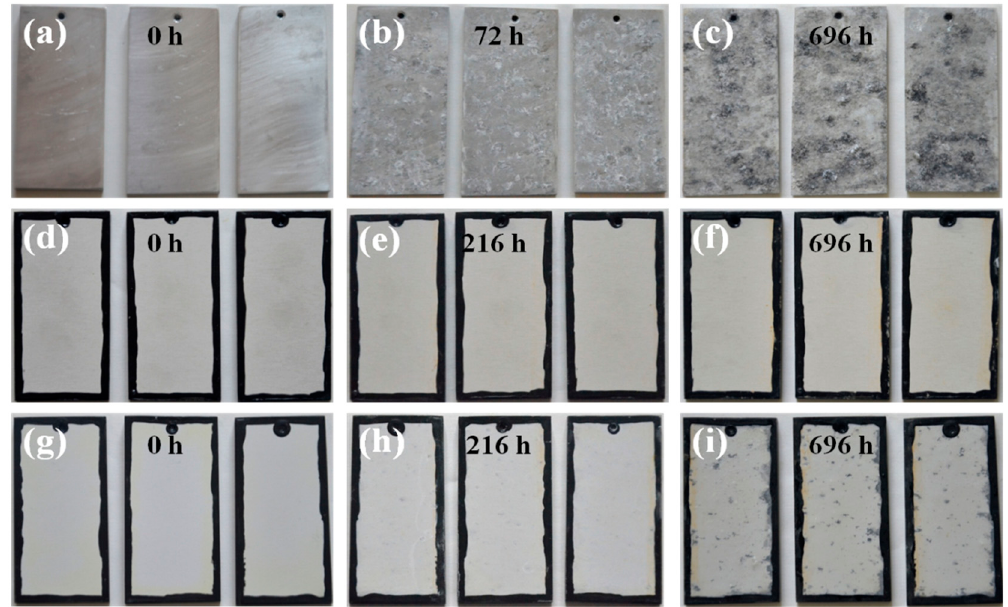
Figure 13. Optical appearance of the PEO coatings after the anti-corrosion property tests in acid 5 wt % NaCl solution (pH = 3.1–3.3) for 696 h: ( a – c ) 6061 Al alloy; ( d – f ) P60; ( g – i ) Al60.